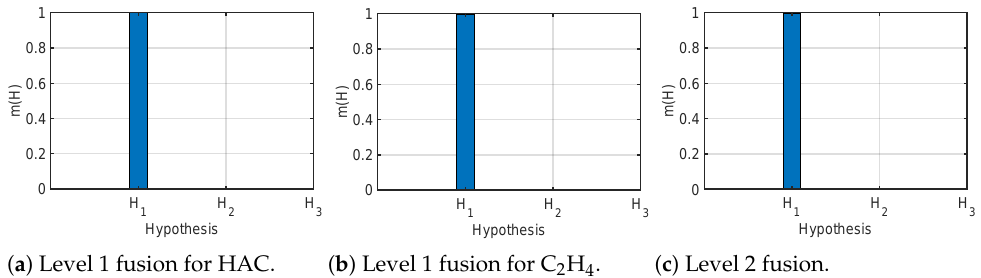
Figure 14. Level 1 and level 2 fusion result. In all cases H 1 = { NORMAL } , H 2 = { NORMAL , ANOMALY } , H 3 = { Θ }